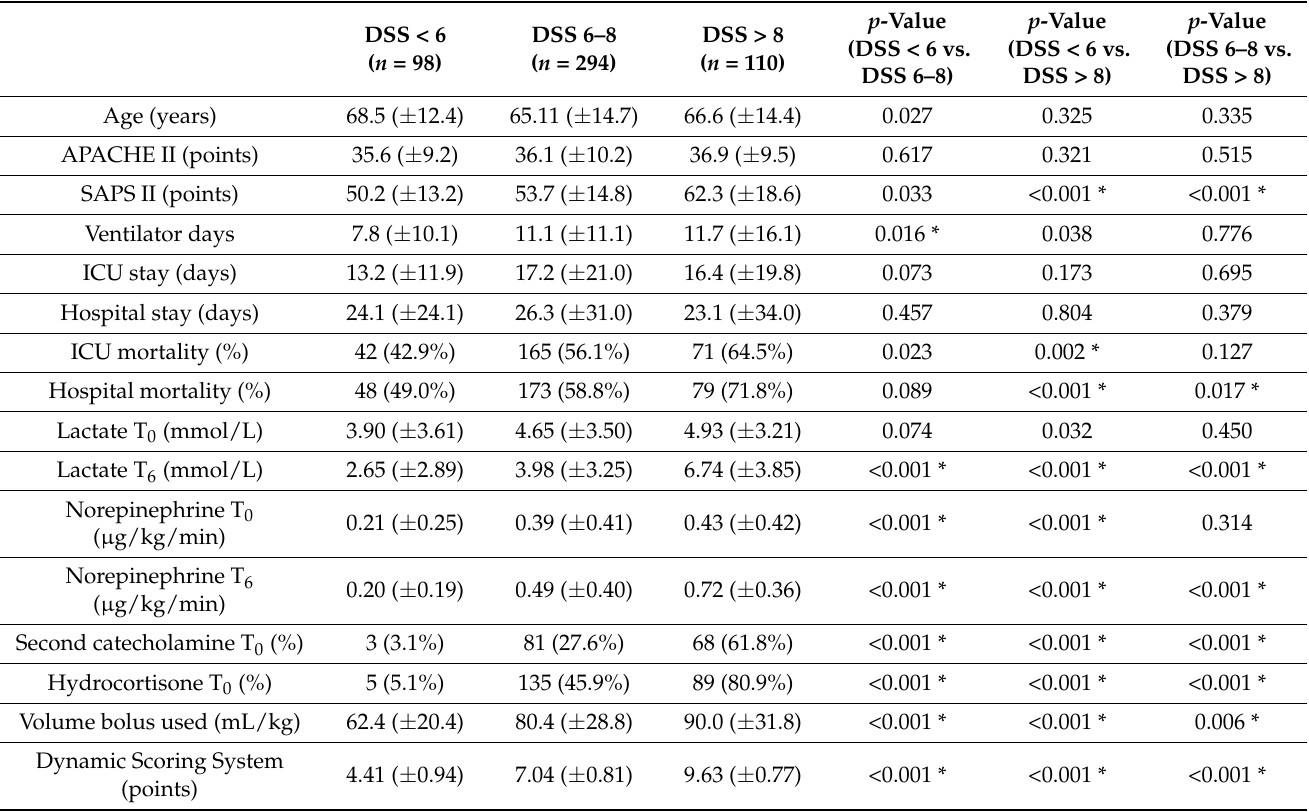
Table 1. Baseline characteristics, DSS relevant parameters and outcome variables depending on score groups in the overall patient cohort. Presented are mean values ± standard deviations, frequency and percent (%) and levels of significance.